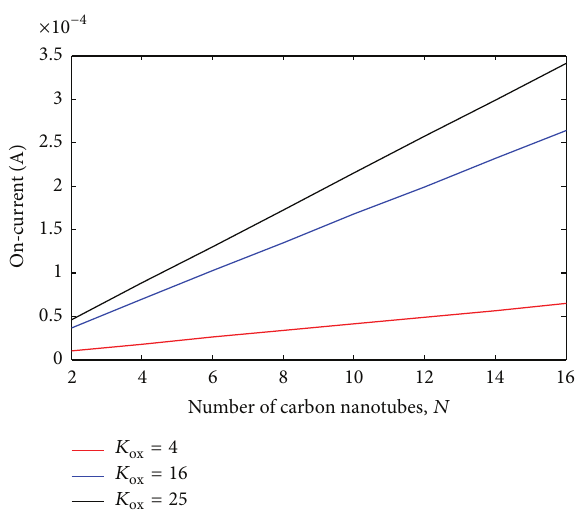
Figure 15: The on-current versus number of carbon nanotubes for different dielectric